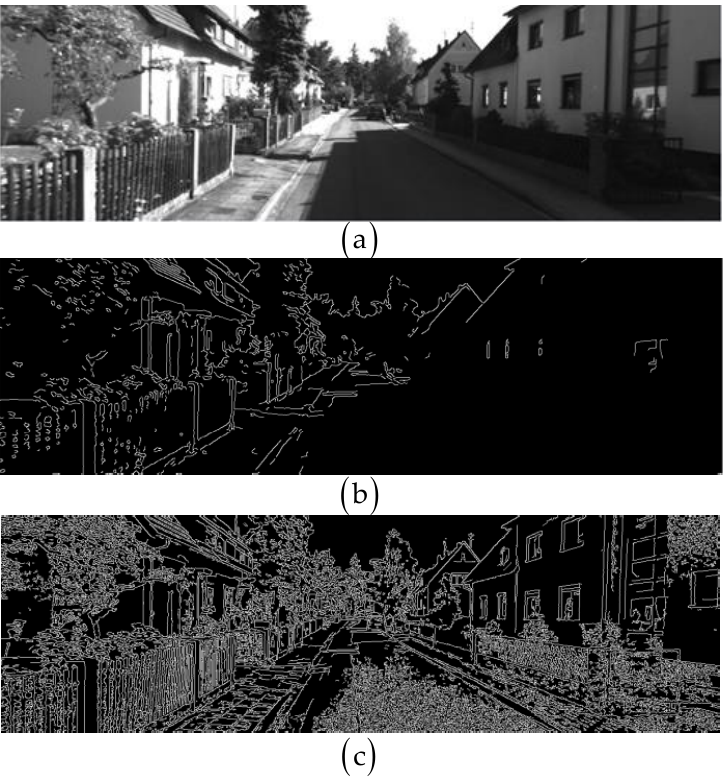
Figure 5. A demonstration of the effect of improving Canny, ( a ) is the original image, ( b ) is the edge image detected by Canny, ( c ) is the edge image detected by improved Canny.